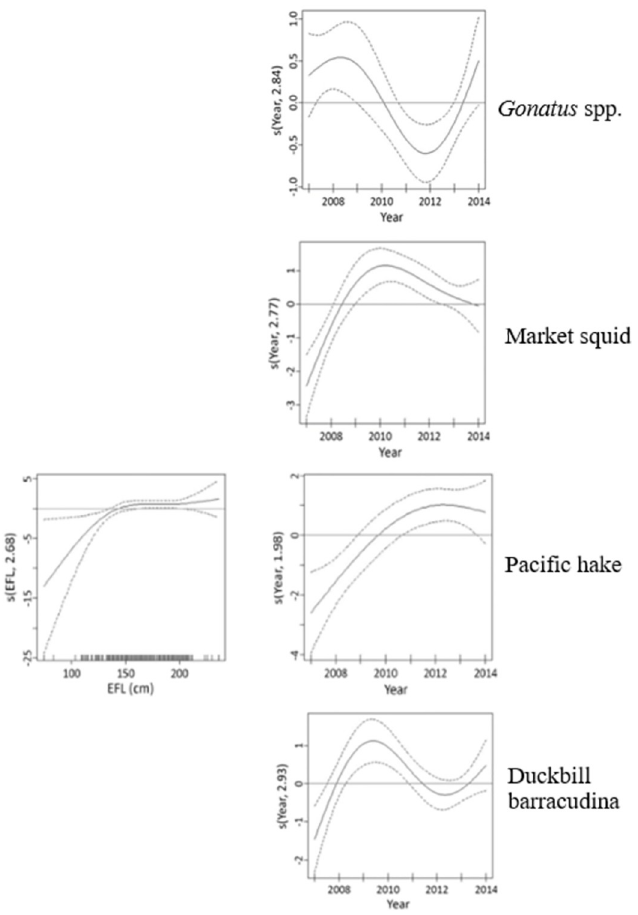
Fig 6. GAM smoothing curves fitted to partial effects of explanatory variables on the presence of 4 prey taxa ( Gonatus spp., market squid, Pacific hake, duckbill barracudina) in the stomach of swordfish. EFL = eye-to-fork length. Dashed lines represent 95% confidence intervals around the main